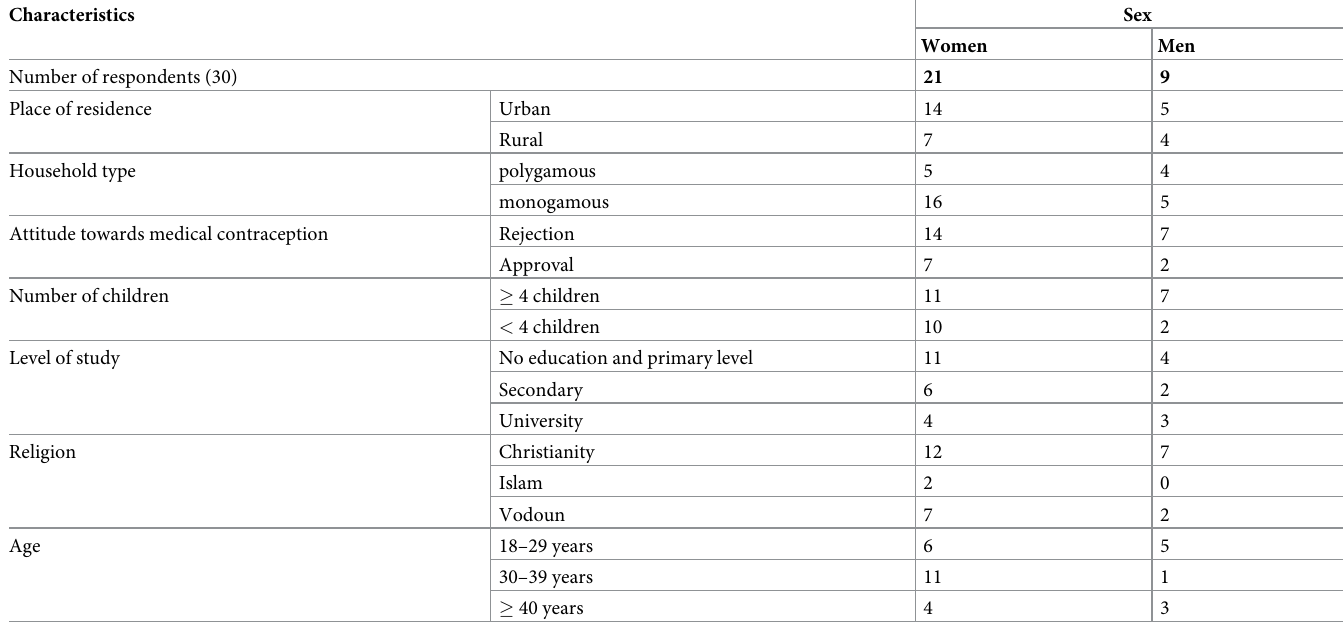
Table 1. Distribution of respondents according to their socio-demographic characteristics.